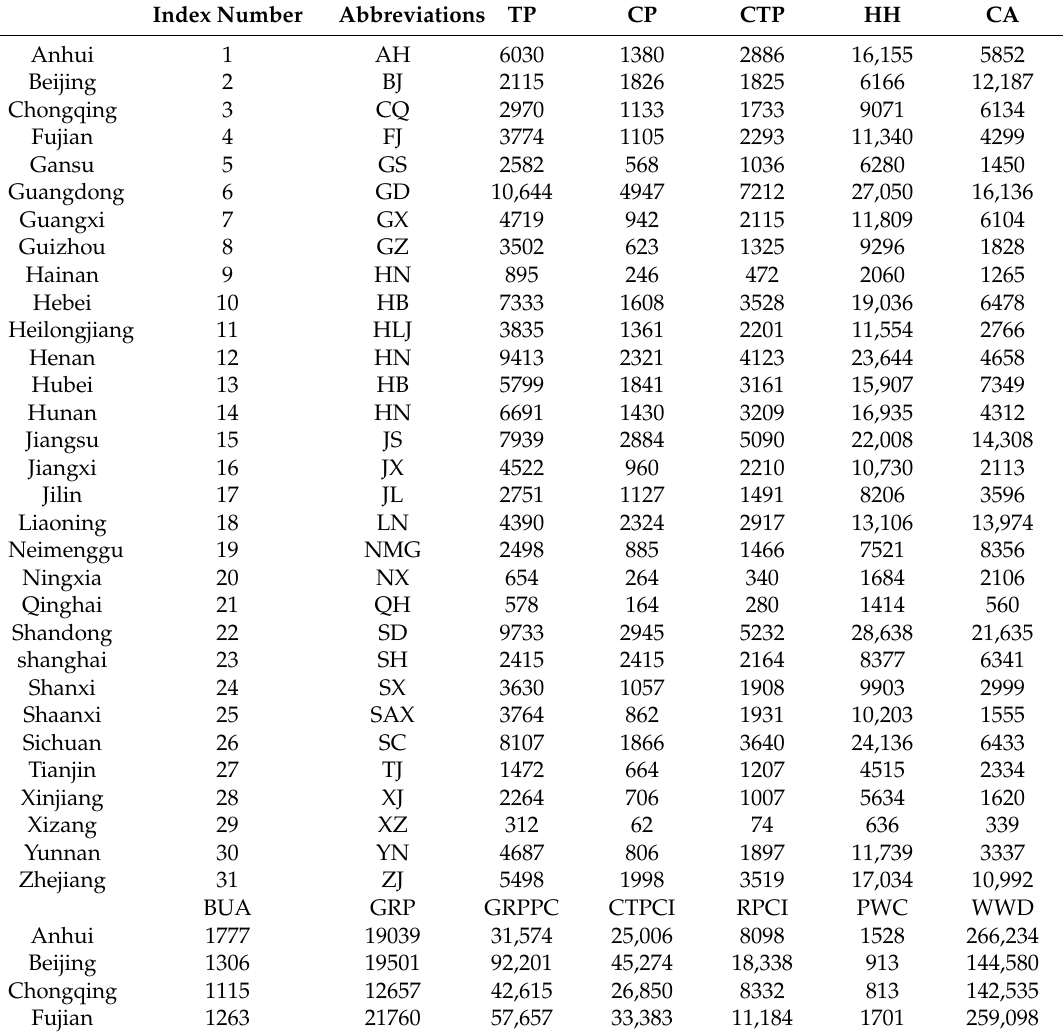
Table A1. Socio-economic parameters during 2013 for 31 provinces in mainland China (units and abbreviations for these socio-economic parameters are listed in Table